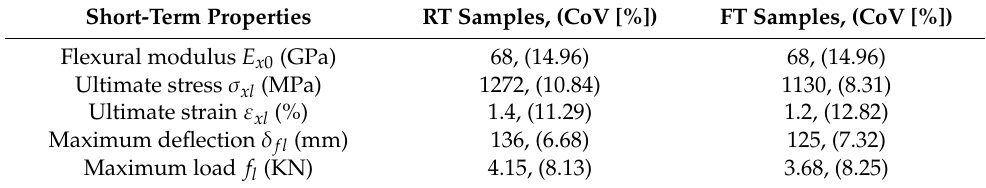
Table 1. Average test results from static bending test with coe ffi cient of variation (CoV).